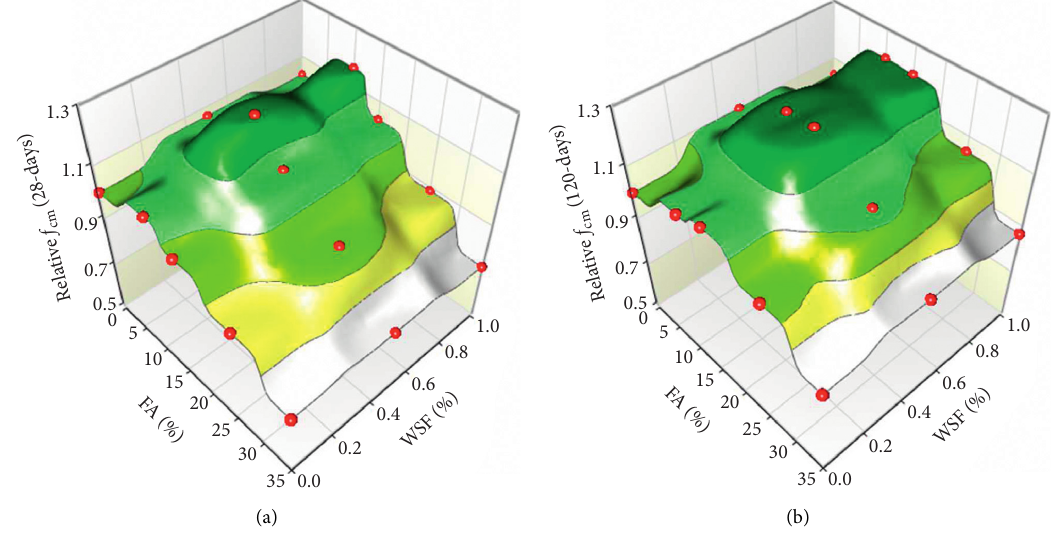
Figure 7: Relationship between FA, WSF, and relative f